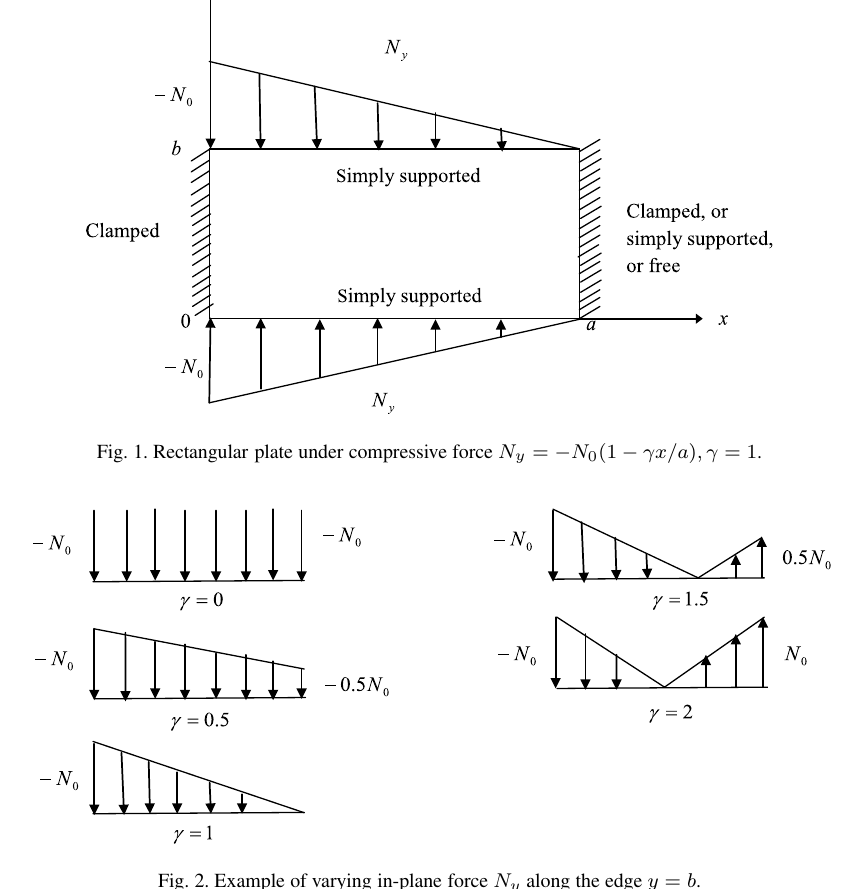
Fig. 2. Example of varying in-plane force N y along the edge y = b